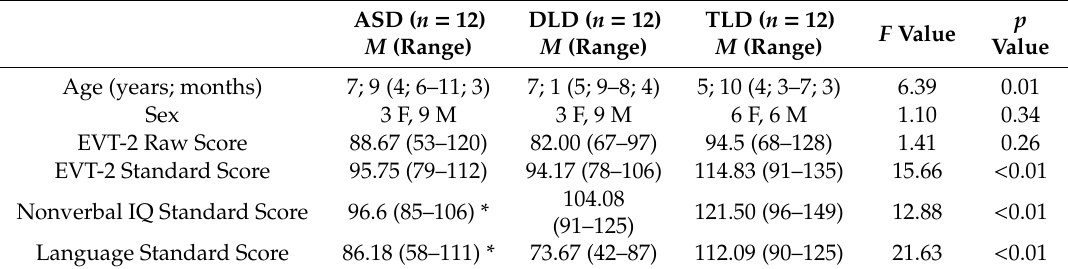
Table 1. Summary of the participant